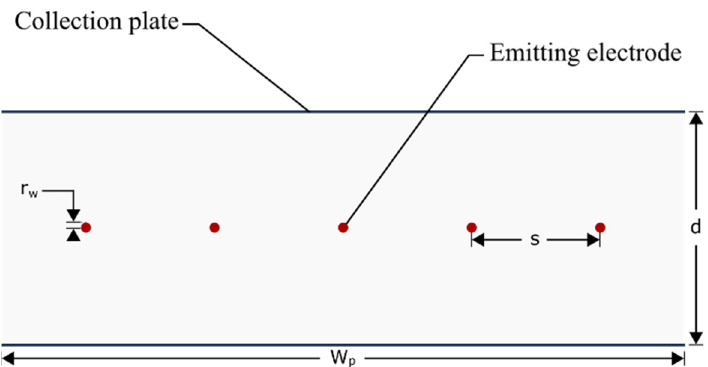
Figure 1. Single-channel wire-plate ESP.